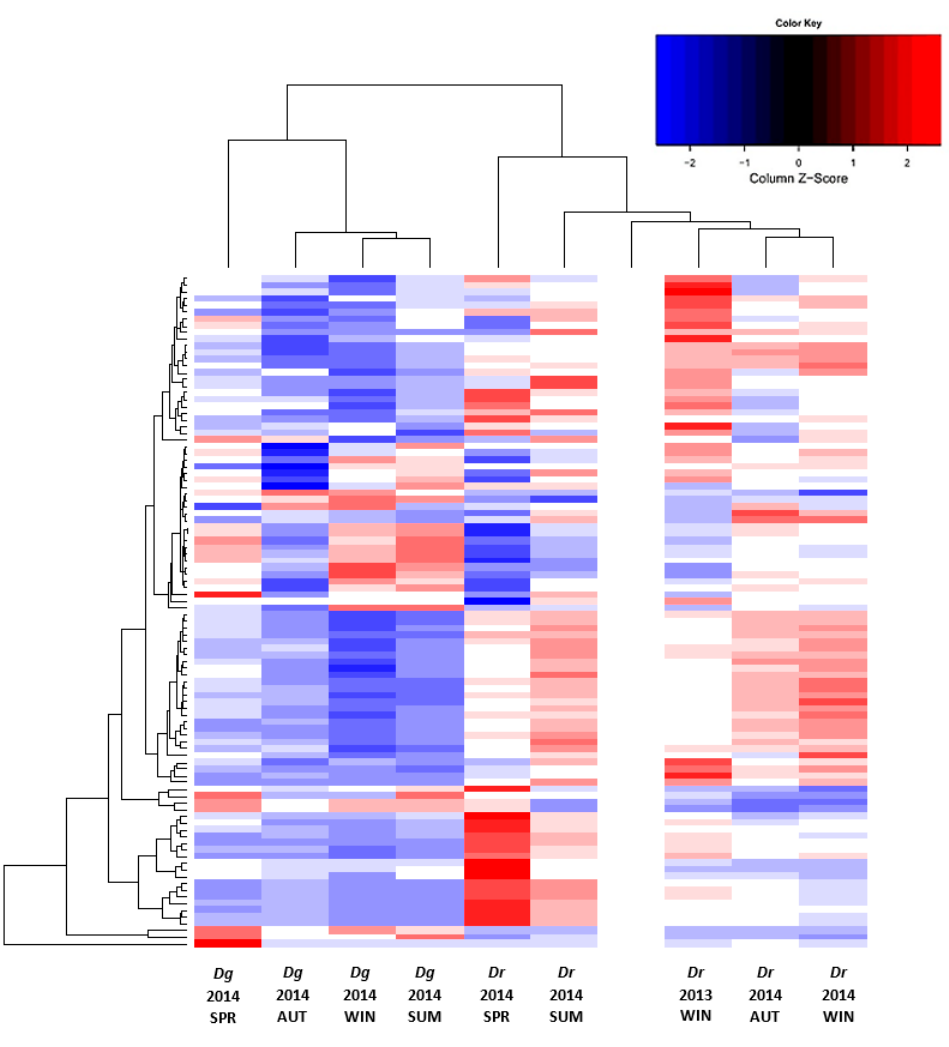
Figure 4. Seasonal metabolic diversity in leaves of D. digyna ( Dg ) and D. rekoi ( Dr ). The metabolic heat map was obtained from acidified methanol extracts obtained from leaves collected from Dg and Dr trees at different seasons: SPR, spring 2014; SUM, summer 2014; AUT, autumn 2014, and WIN, winter, 2013 and 2014 (for ( Dr ) and 2014 ( Dg )). The 100 most abundant ionizable metabolites were selected to obtain the metabolic heat map within an 80–1300 m/z range. All measurements were performed in triplicate. The color-coded matrix elements and adjacent dendrograms indicate the functional relationships among the following variables: 100 ionizable metabolites’ abundance, detected by untargeted direct-injection electrospray mass spectrometry (DIESI-MS) analysis; two Diospyros tree species; and five seasons. The blank column represents a solvent control used to calibrate the system .